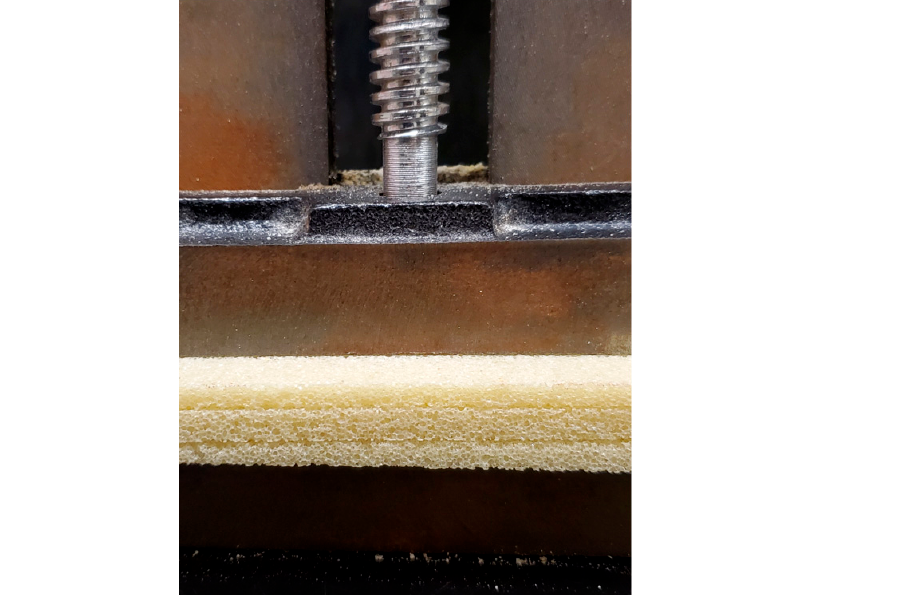
Figure 1. Polyurethane foam laminas. This image illustrates the setting of three superimposed lam- inas clamped with a vice. The thickness of each lamina is 3.3 mm, and the total thickness of the three laminas all together was ±10 mm. Table 1. Drill manufacturer, drill type, reference, wall angle, and tip angle.